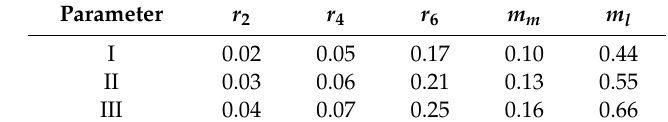
Table 5. Values of heat convection parameters.